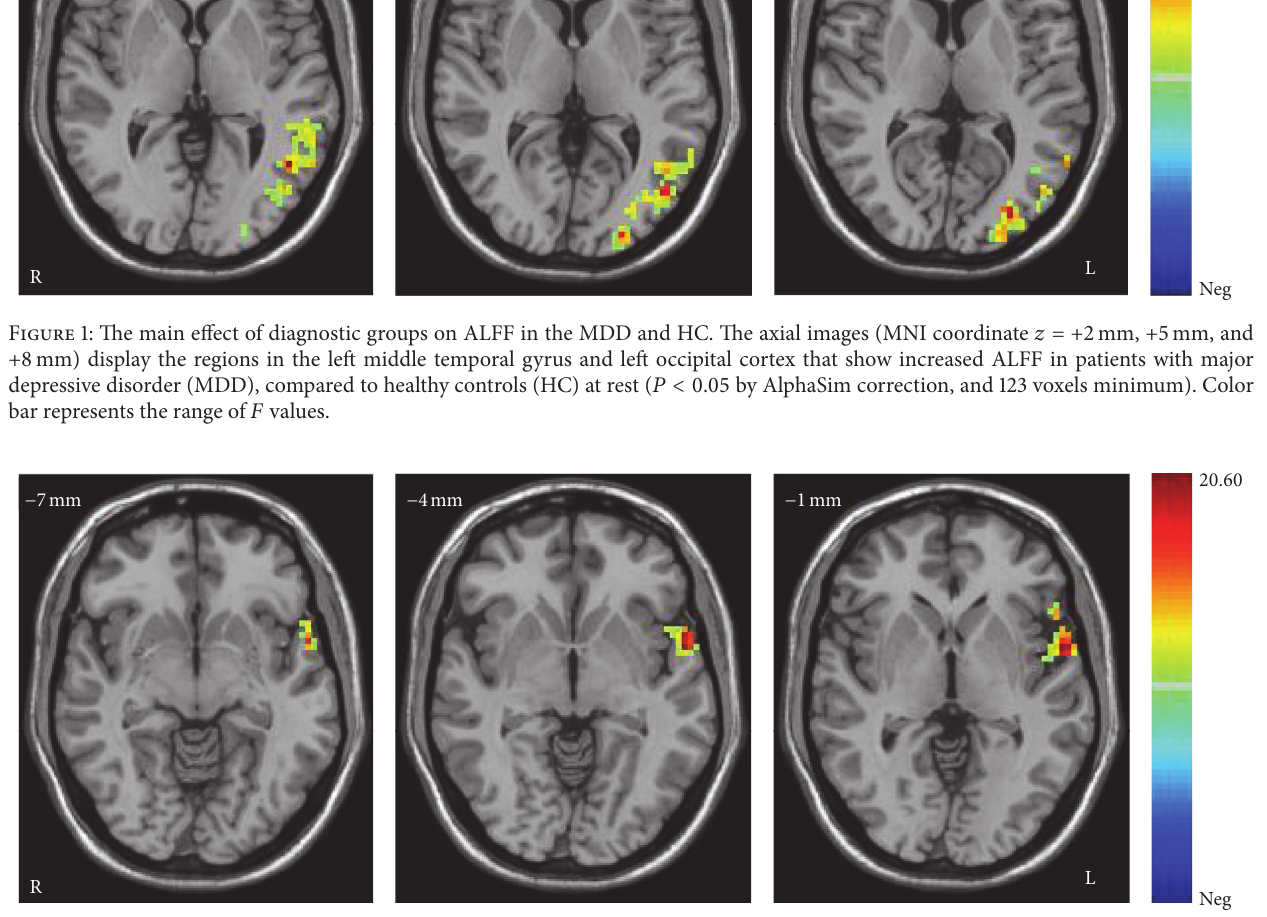
Figure 2: Main effect of genotypes on ALFF in the MDD and HC. The axial images (MNI coordinate 𝑧 = − 7mm, −4 mm, and −1 mm) display the regions in the left superior temporal gyrus that show increased ALFF in the T-carrier group ( 𝑃 < 0.05 by AlphaSim correction, and 123 voxels minimum). Color bar represents the range of 𝐹